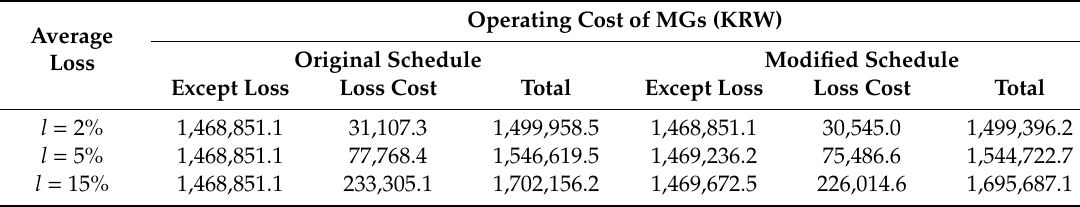
Table 6. Operating cost of MGs according to di ff erent power sharing